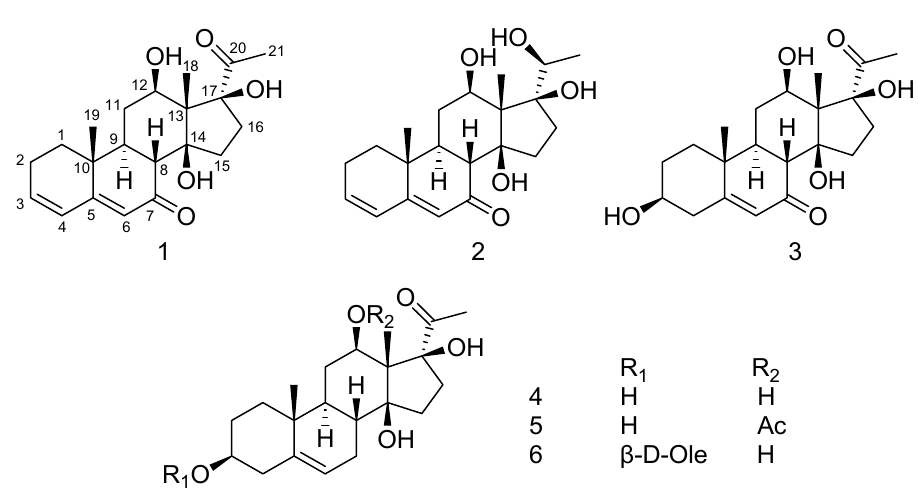
Figure 1. Structures of compounds 1 – 6 .